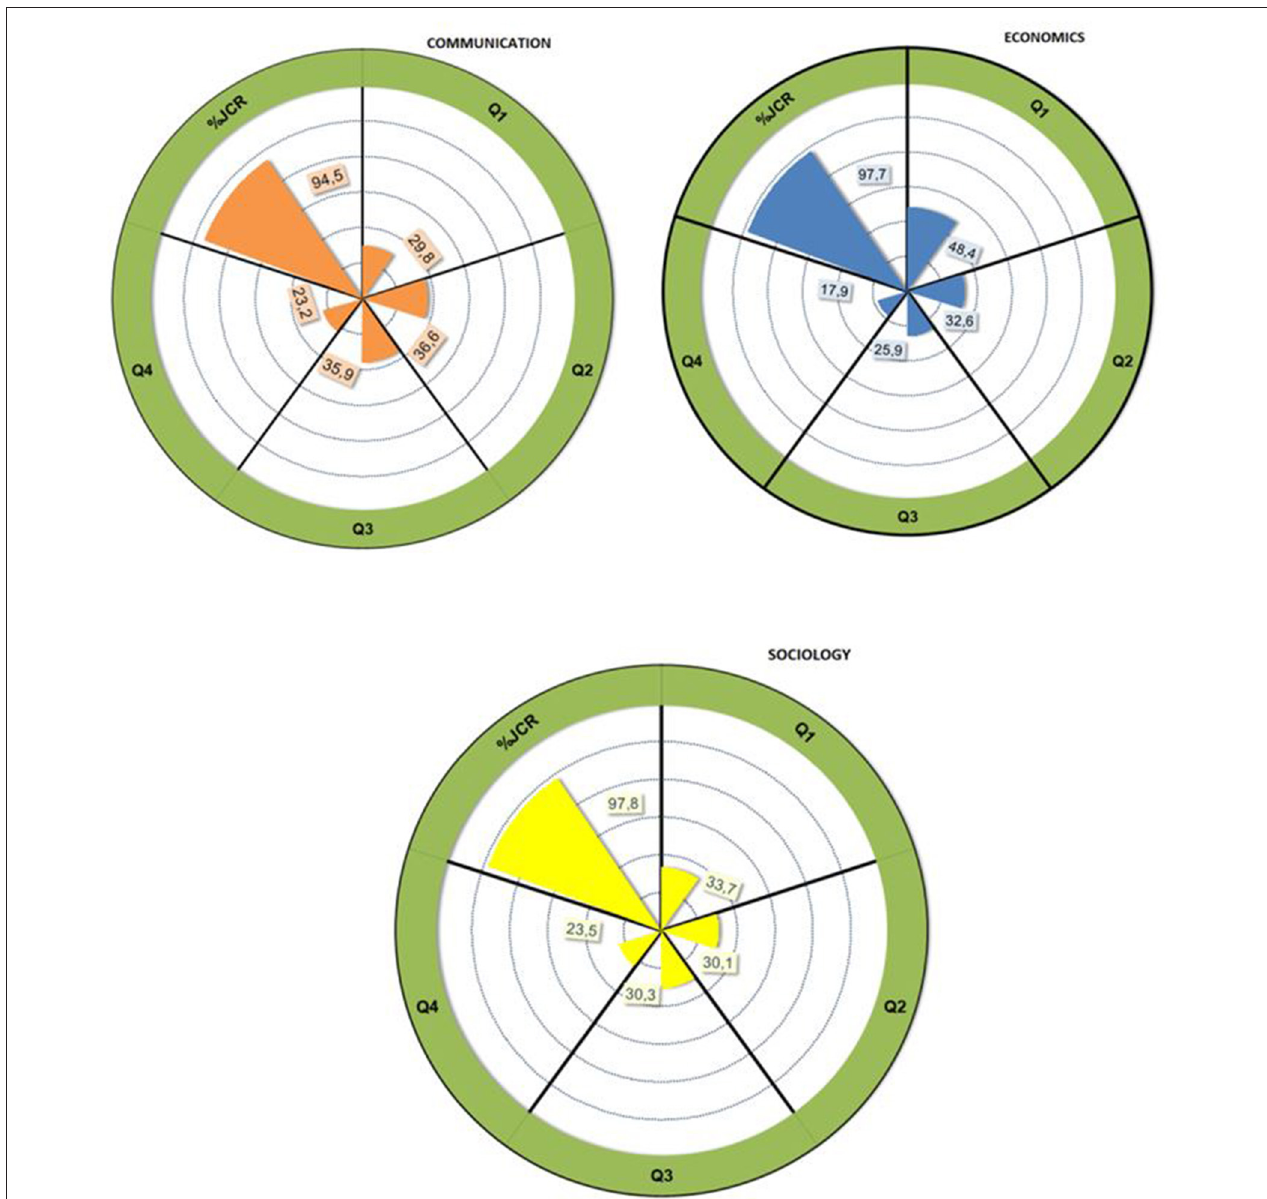
FIGURE 2 | Publications by quartile and